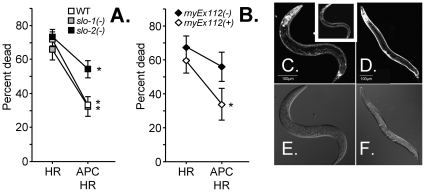
APC in C. elegans requires slo-2.
(A) C. elegans WT control (N2-Bristol), slo-1(js379)V and slo-2(nf100)X mutants were subjected to hypoxia-reoxygenation (HR) and isoflurane APC+HR, as detailed in the methods section of Supporting Information S1. Viability is expressed as percent of dead worms. Means ± SEM, N>11, (N = independent trials of >100 worms per trial), *p<0.05 vs. HR. (B) HR and APC+HR of fluorescent slo-2(nf100)X mutant C. elegans containing an extrachromasomal array derived from a mixture of a SLO-2:mCherry gene fusion and the WRM061CF07 fosmid (rnyEx112(+)) compared to their non-fluorescent siblings that had lost the array (rnyEx112(-)). Means ± SEM, N = 4 (N = independent trials of >100 worms per trial), *P<0.05 vs. HR. (C–F) Fluorescent confocal maximum projection (C, D) and corresponding DIC (E, F) images of C. elegans expressing SLO-2:mCherry (C, E) or SLO-2:GFP protein fusions (D, F) in neurons and muscle via the native slo-2 promoter. The white inset in panel C shows a single confocal slice obtained close to the surface of the worm, showing clear body wall muscle plasma membrane localization of the mCherry fusion protein.